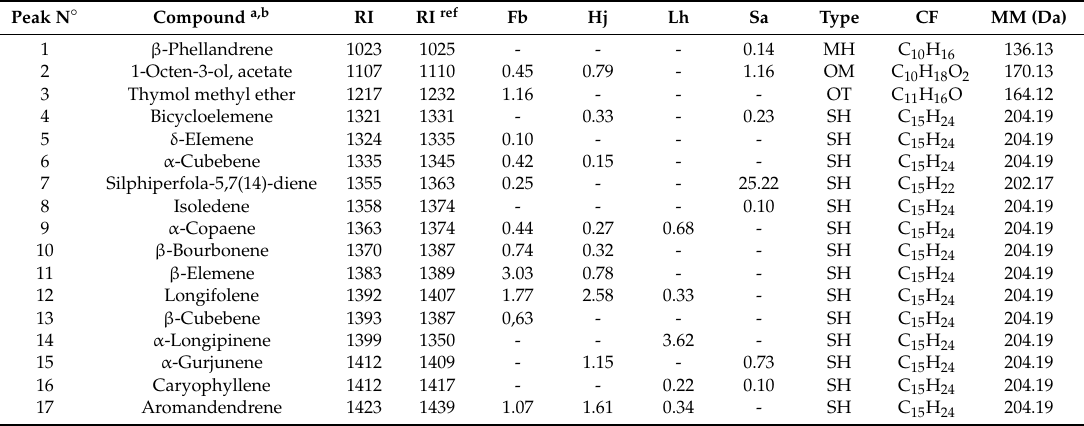
Table 1. Volatile metabolites of Frullania brasiliensis (Fb), Herbertus juniperinus (Hj), Leptoscyphus hexagonus (Lh), and Syzygiella anomala